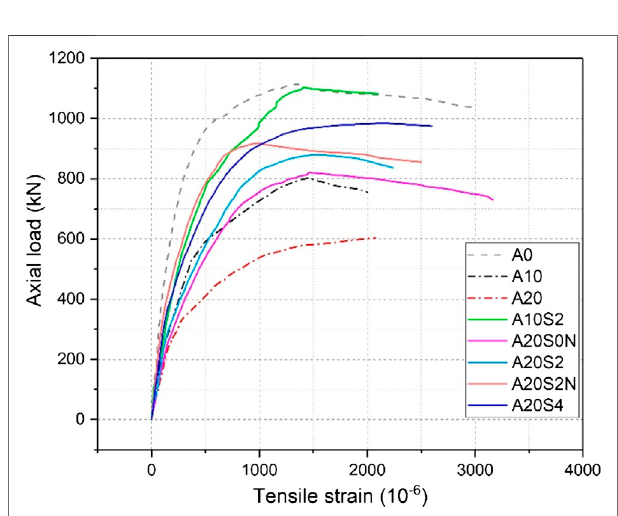
FIGURE 12 | Tensile strain of stirrups.